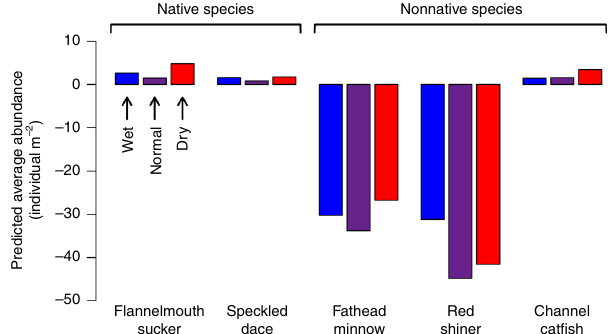
Fig. 5 Fish species abundance gains or losses according to the designer fl ow prescription. Designer fl ow prescription indicated by triangle symbols in Fig. 2.Values are averaged across three-year periods under wet (blue fi ll), normal (purple fi ll), and dry (red fi ll) climatic scenarios. Species responses are based on fl ow designs that heavily prioritized human water needs and gave equal consideration to native fi sh bene fi t ( Rhinichthys osculus and Catostomus latipinnis ) and nonnative fi sh detriment ( Cyprinella lutrensis , Pimephales promelas , and Ictalurus punctatus